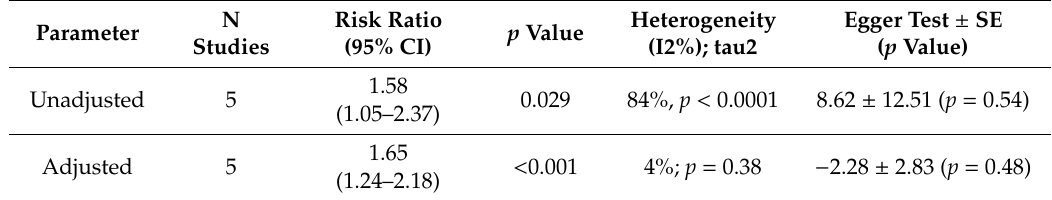
Table 1. Risk ratios (unadjusted and adjusted) for all-cause mortality (ACM) of patients with gastrointestinal cancers, based on pSmad2- vs. pSmad2 +